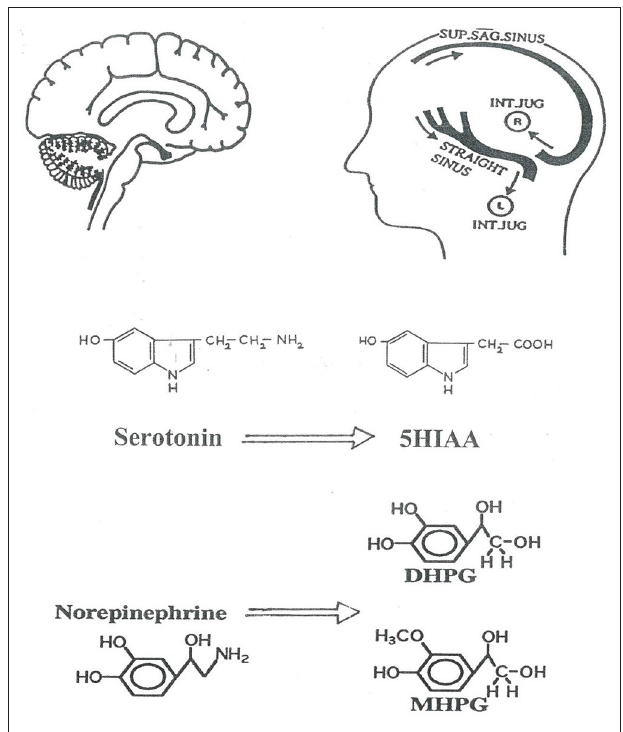
FIGURE 1 | Schematic representation of the investigation of human brain monoamine turnover, utilizing internal jugular venous sampling and the assay or serotonin and noradrenaline metabolites in plasma, to measure jugular venous—arterial plasma concentration differences. 5HIAA, 5-hydroxyindoleacetic acid is the principal metabolite of serotonin; DHPG, dihydroxyphenylglycol; MHPG, 3-methoxy-4-hydroxyphenylglycol are lipophilic metabolites of norepinephrine which cross the blood-brain barrier. The lateralization of cerebral venous sinus drainage is represented, explained in Figure 2 . SUP. SAG. SINUS, Superior Sagittal Sinus; INT. JUG., internal jugular